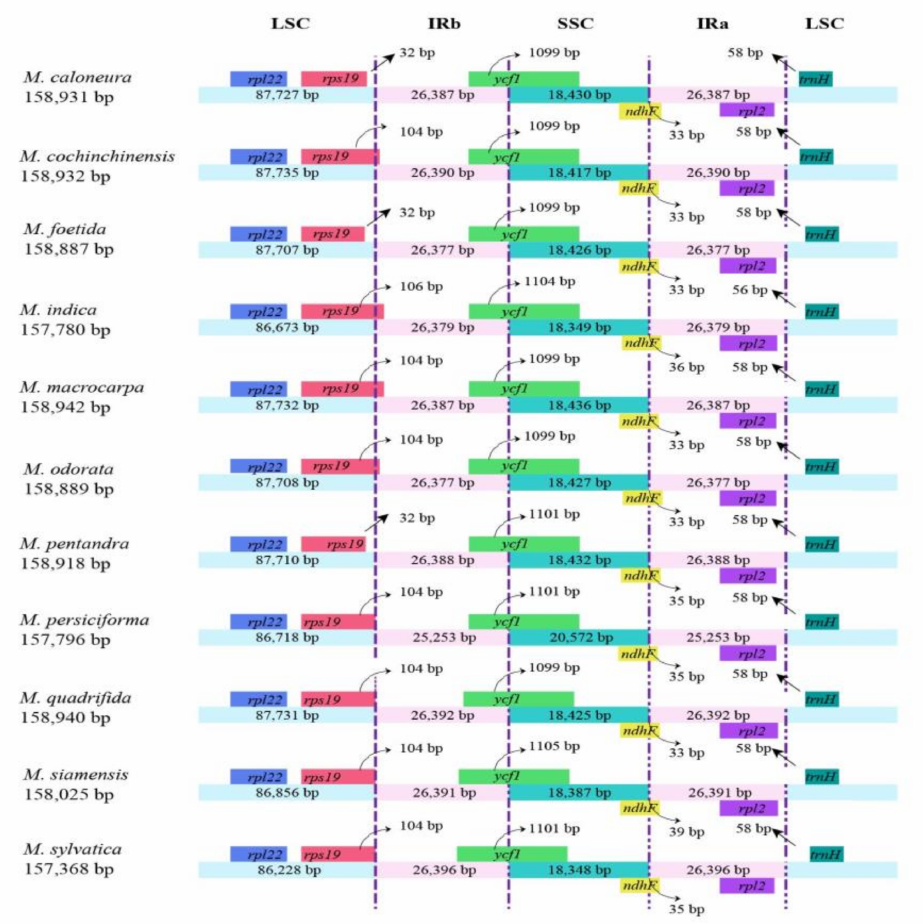
Figure 2. Comparison of large single-copy (LSC), small single-copy (SSC), and inverted repeat (IR) borders among the 11 chloroplast genomes of Mangifera